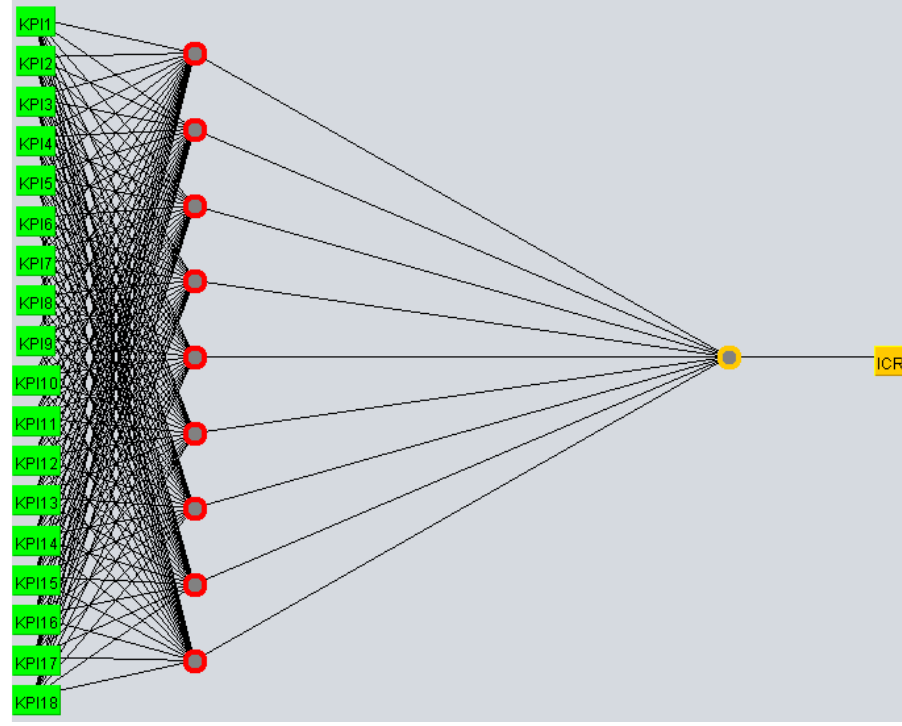
Figure 4. Competitiveness measurement model through Artificial Neural Network.